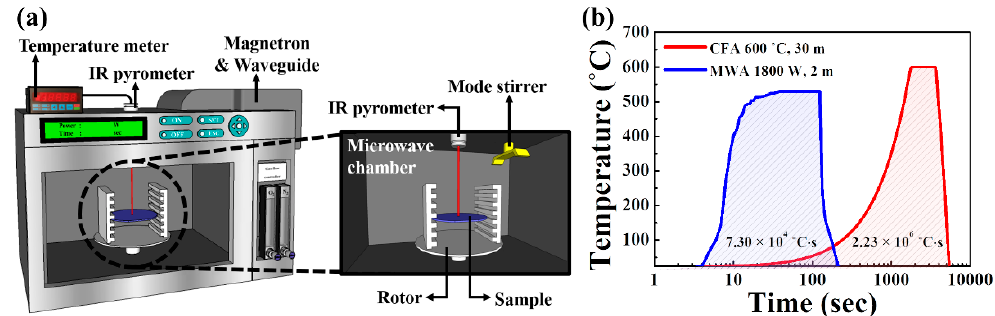
Figure 2. ( a ) Schematic of microwave irradiation system. ( b ) Temperature profiles of microwave annealing (MWA) and conventional furnace annealing (CFA) calcination processes.